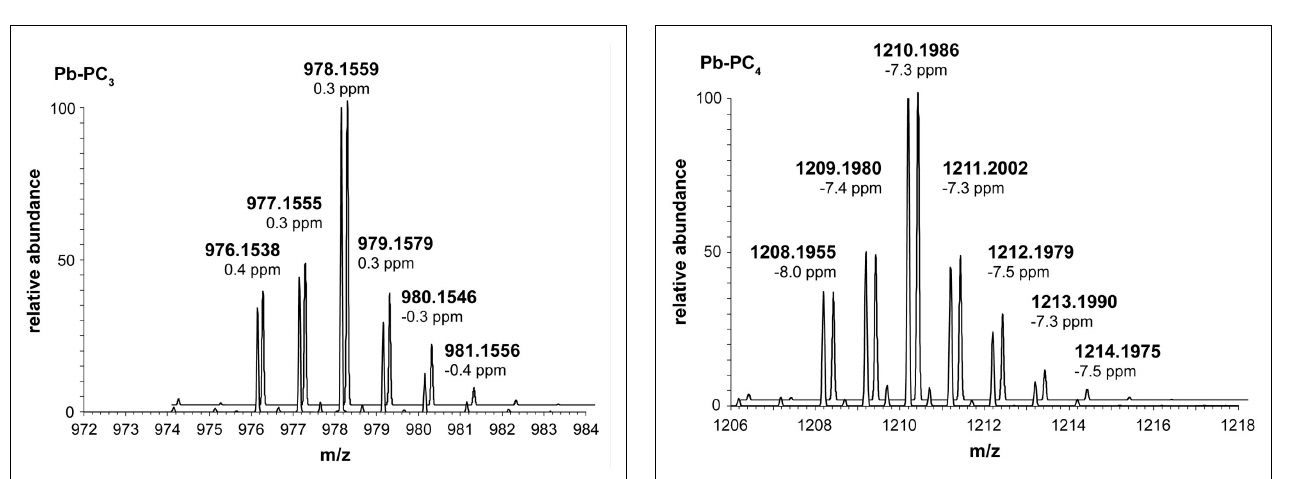
FIGURE 6 | Measured (front) and simulated spectrum (back) of the isotopic pattern of the [Pb–PC 4 ] + complex m / z 1,206–1,218. Isotopic